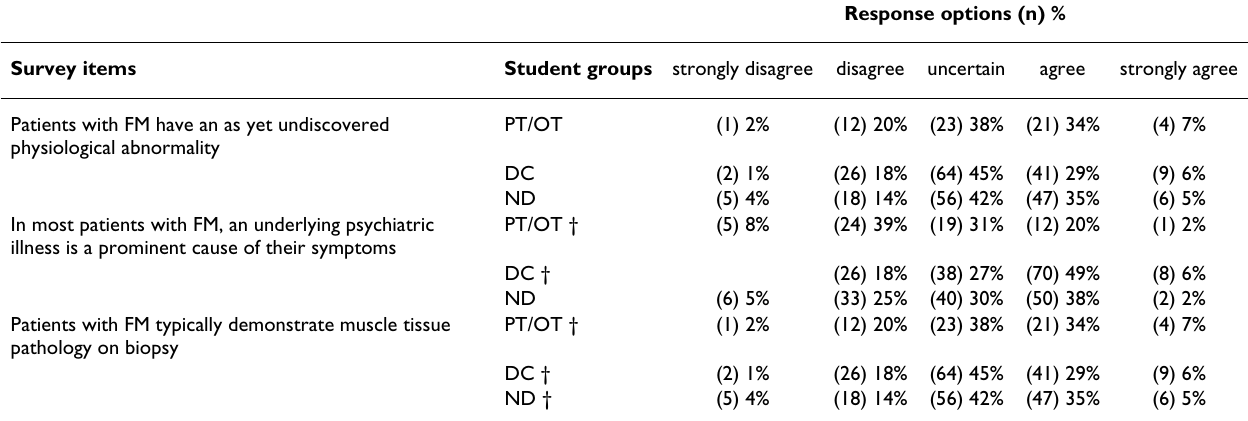
Table 1: Response data to questions on the etiology of fibromyalgia